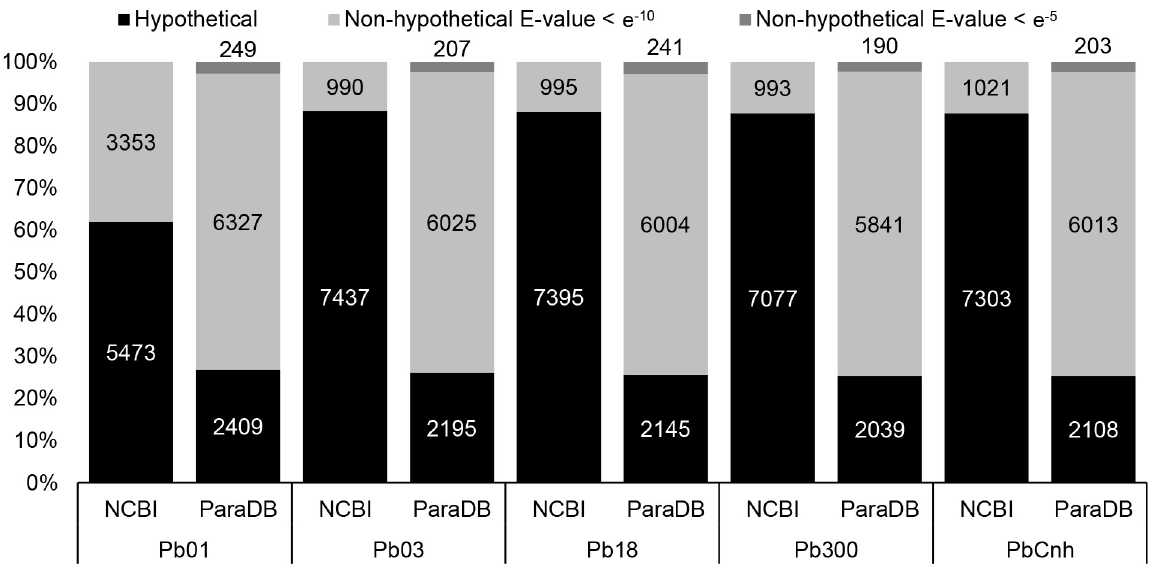
Fig 1. Quantitative assessment of hypothetical and non-hypothetical proteins annotated in the Paracoccidioides spp. genomes. The graph indicates the percentage of hypothetical and non-hypothetical proteins present in the ParaDB annotation, when compared to the official annotations available through GenBank/RefSeq, showing that the proportion of CDSs annotated solely as hypothetical proteins was reduced from ~60–90% to ~25–28%, in all strains. Figure also shows the absolute number of CDSs with functional classification, identified at high stringency (E-value < e -10 ) and low stringency (E-value < e -5 ) BLAST analyses, as well as CDSs that remained identified as hypothetical proteins, in the genomes of each Paracoccidioides